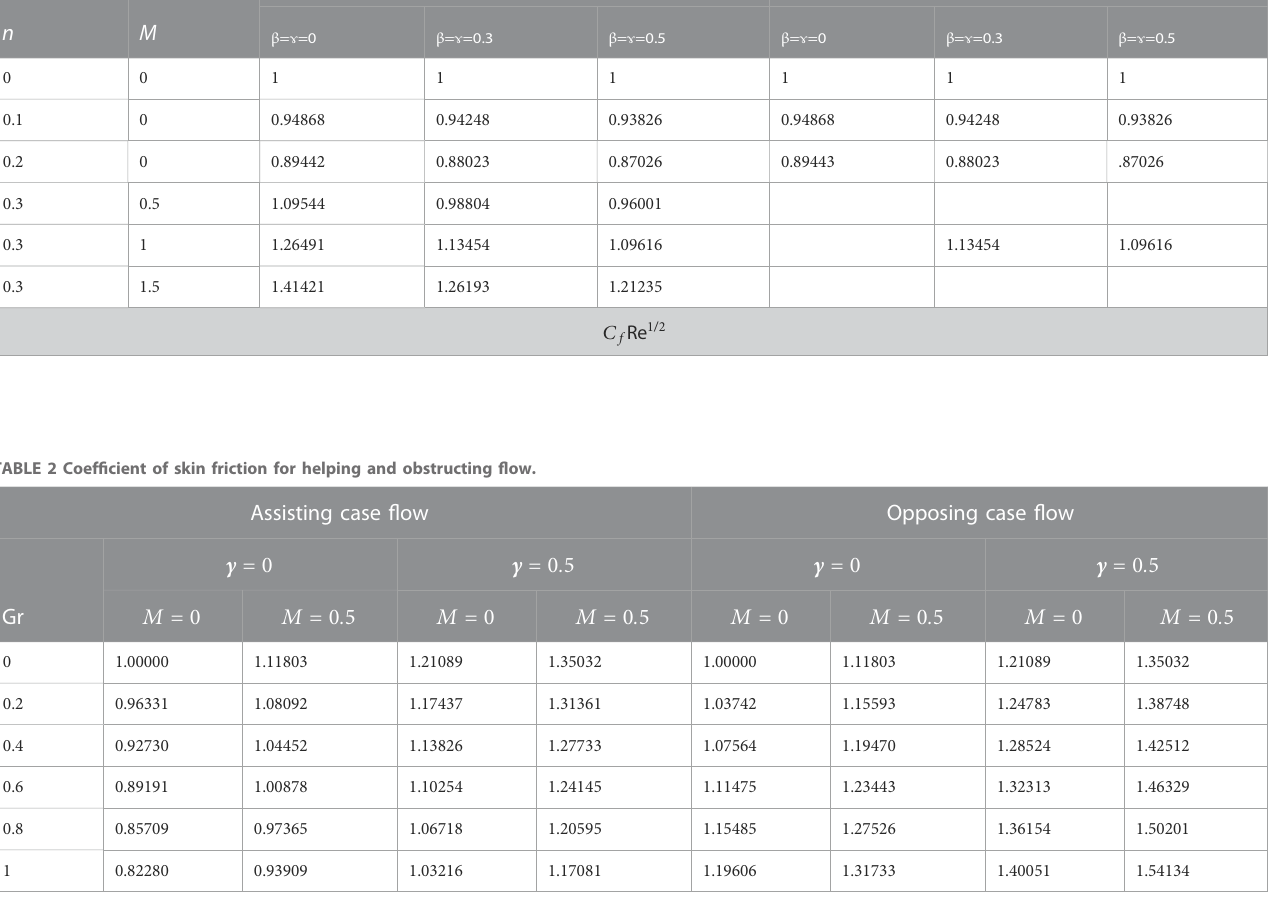
TABLE 1 Comparison of coef fi cient of skin friction with [*] for G r (cid:1) 0 . Akbar et al. (Akbar et al., 2015)